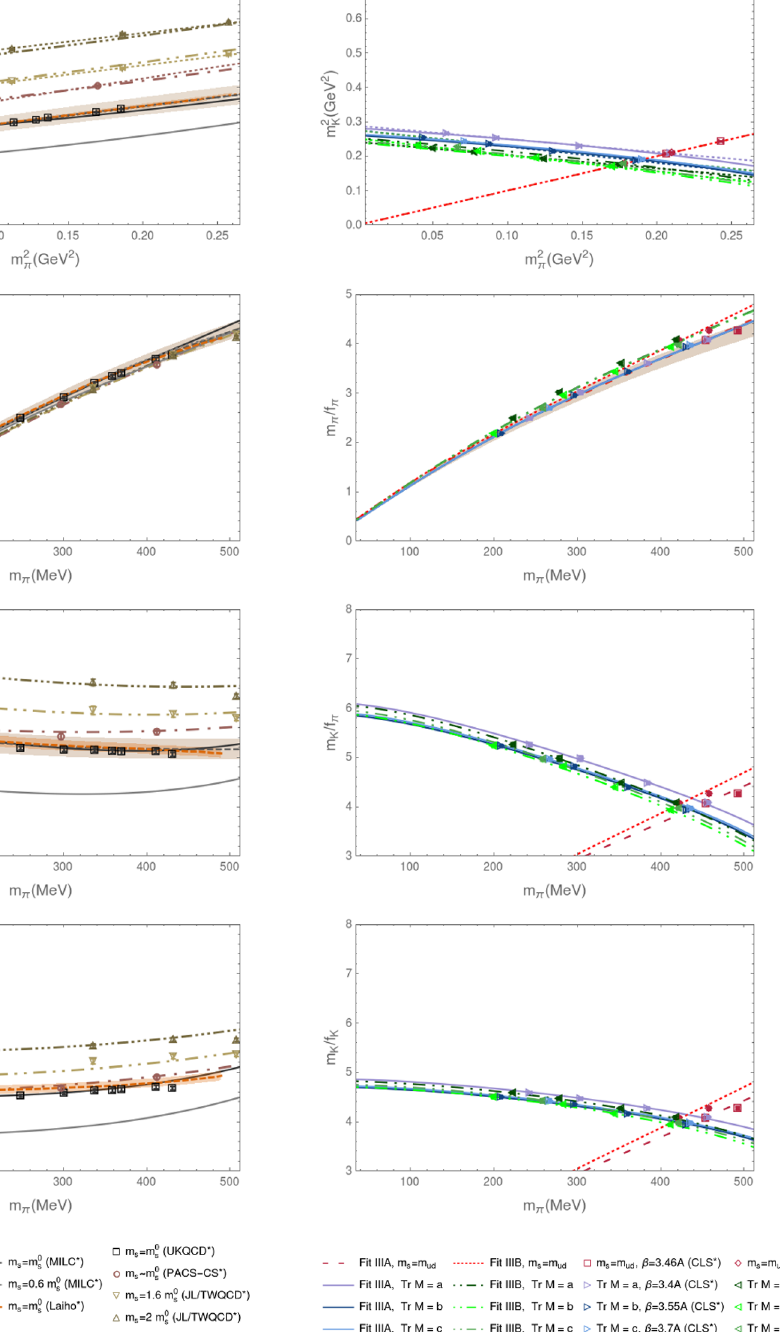
Figure 5 . Chiral trajectories (top) and ratios m (cid:25) =f (cid:25) , m K =f (cid:25) , and m K =f K obtained in (cid:12)ts II, PACS-CS, and JL/TWQCD, (left), and IIIA(B) (right), from tables 3, 4, 6, and 7. Values with ( (cid:3) ) denote lattice data.